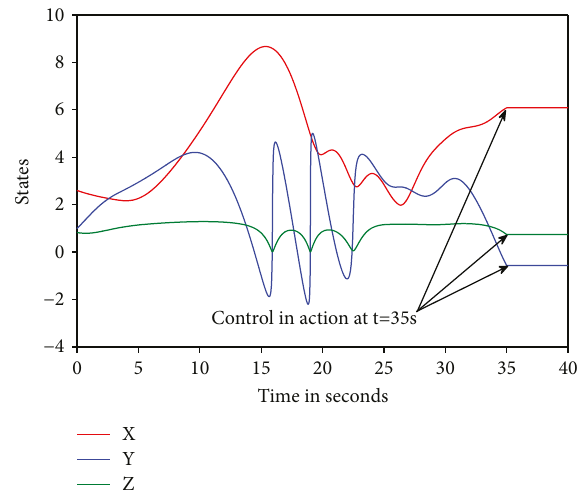
Figure 4: Time history of the states with control in action at t = 0s .